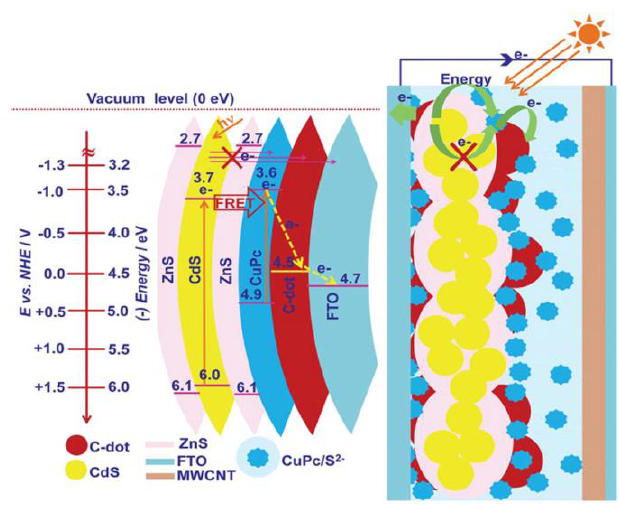
Figure 9. Energy band diagram showing possible paths for energy and charge transport and structure of the FTO/ZnS-CdS-ZnS/CDs/CuPc/S 2− /MWCNT devices. Reproduced with permission of [33].